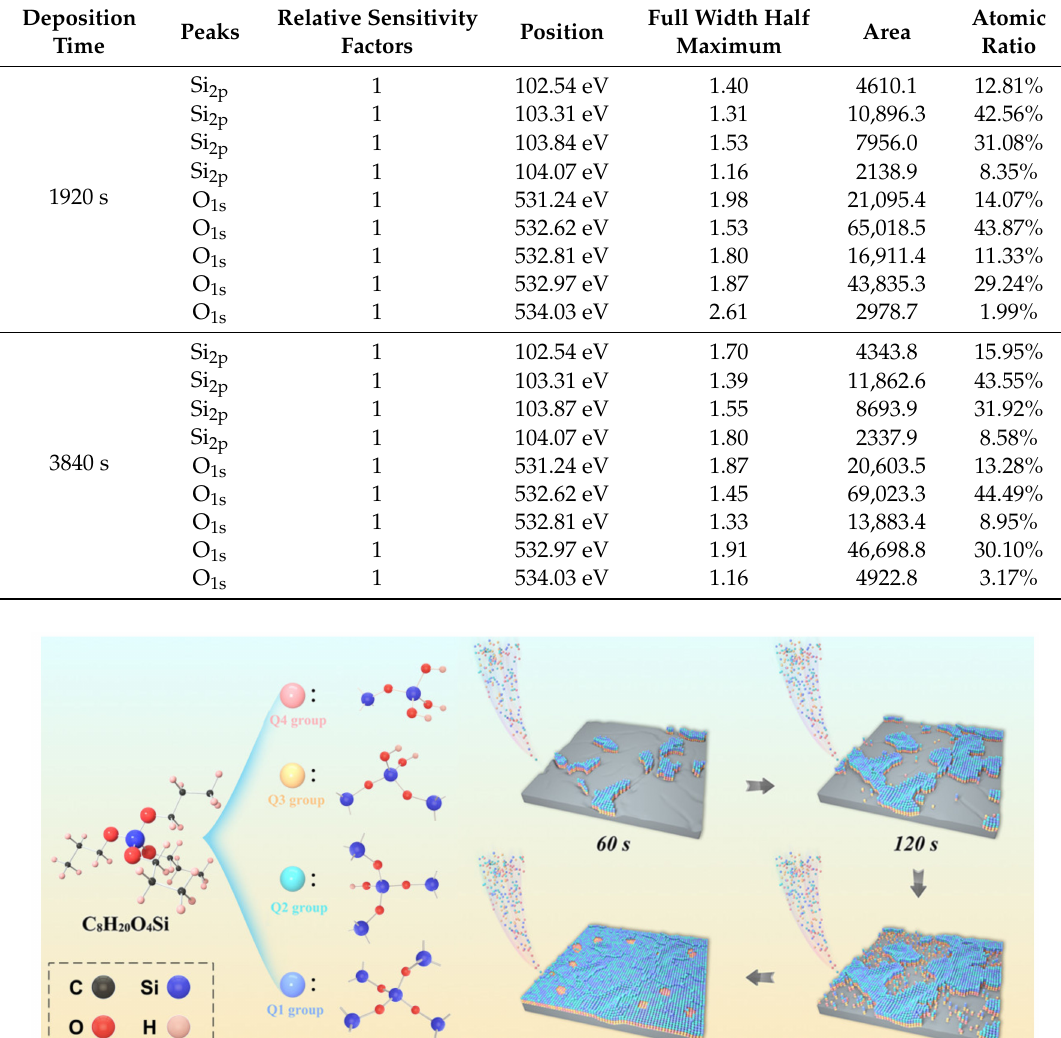
Table 2. Quantitative elemental analysis of Si 2p and O 1s on the surfaces of Fe-6.5wt.%Si / SiO 2 composite particles after deposition for 1920 s and 3840 s.